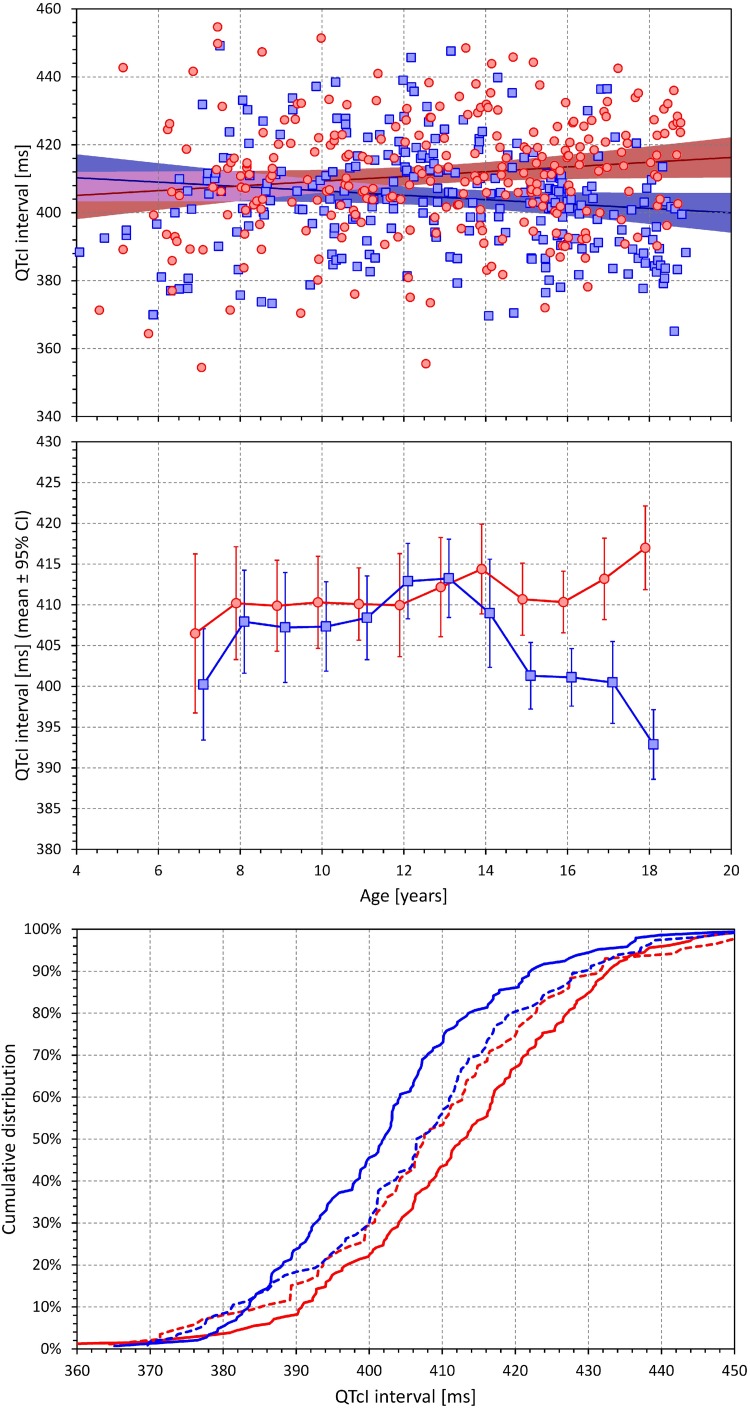
The (top) panel shows the scatter diagram between age and QTcI interval (see the legend of Figure 2 for symbol explanations). The (middle) panel shows the averages of QTcI intervals in age bands <8 years, 7–9 years, 8–10 years, etc. up to 16–18 years, and >17 years (each shown approximately at the middle age of the band). The error bars are the corresponding standard deviations. The red and blue marks correspond to the females and males, respectively. The (bottom) panel shows the cumulative distributions of QTcI intervals in subjects without (dashed lines) and with (full lines) secondary sex signs. The red and blue lines again correspond to females and males, respectively.